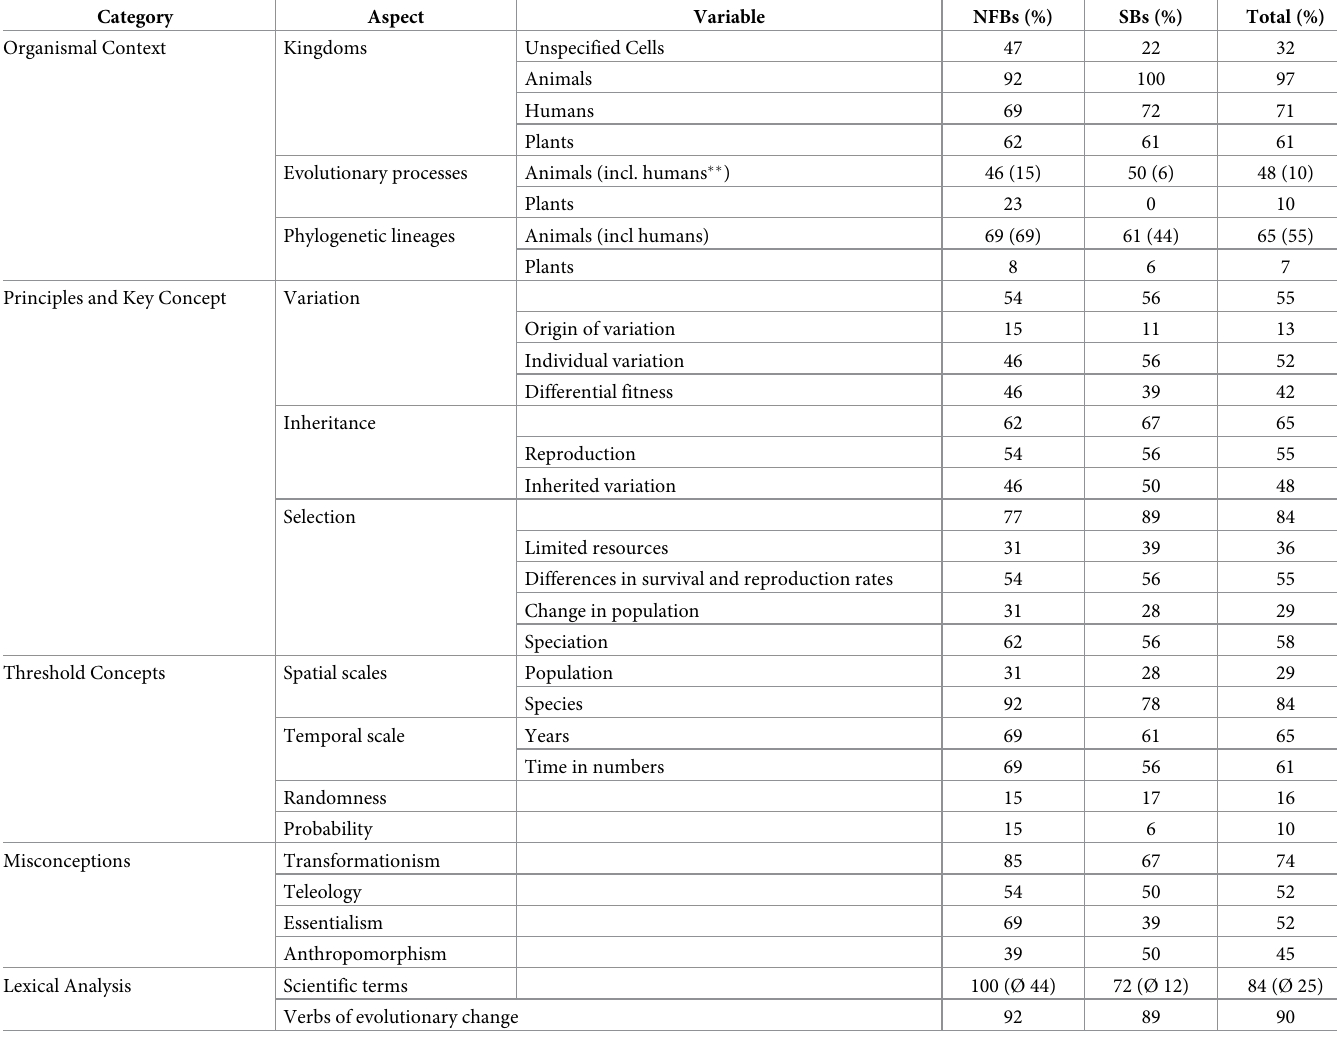
Table 2. Major findings of the content analysis for all categories in NFBs � ( n = 13) and SBs ( n = 18). Category